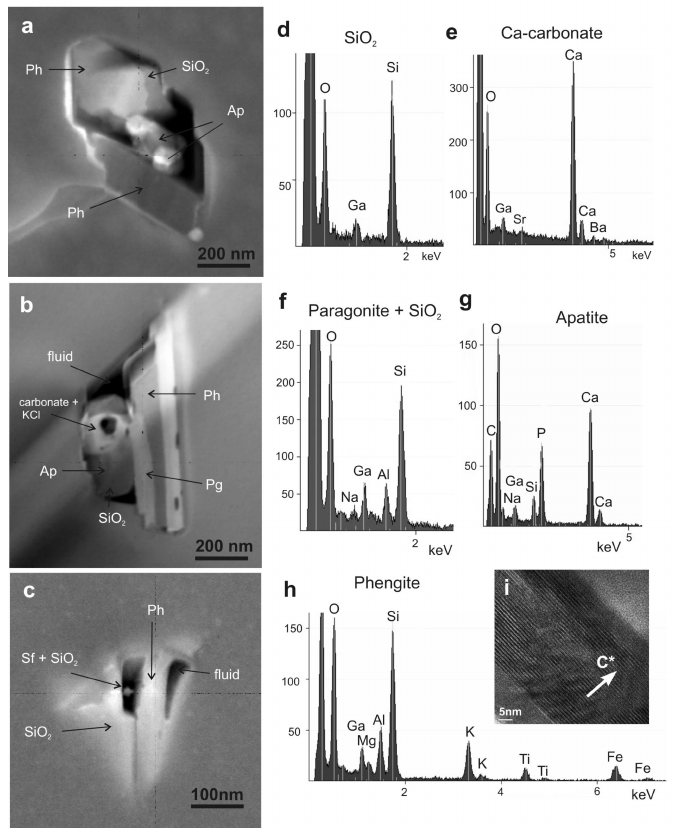
Figure 4. ( a – c ) TEM bright field image of the nanometer-sized polyphase inclusions: diamond HI-91, foil #2793, inclusion 5 ( a ) and inclusion 2 ( c ); diamond HI-95, foil #2800, inclusion 2 ( b ). The main phases are indicated: Ph (phengite), Ap (apatite), Pg (paragonite), Sf (sulfide). ( d – h ) EDX spectra